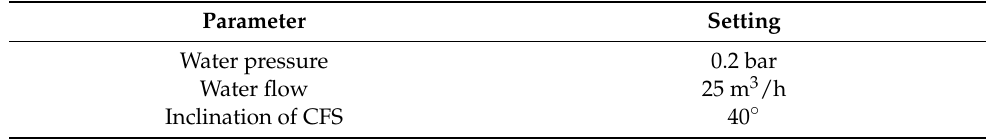
Table 10. Operating parameters of the centrifugal force separator (CFS).